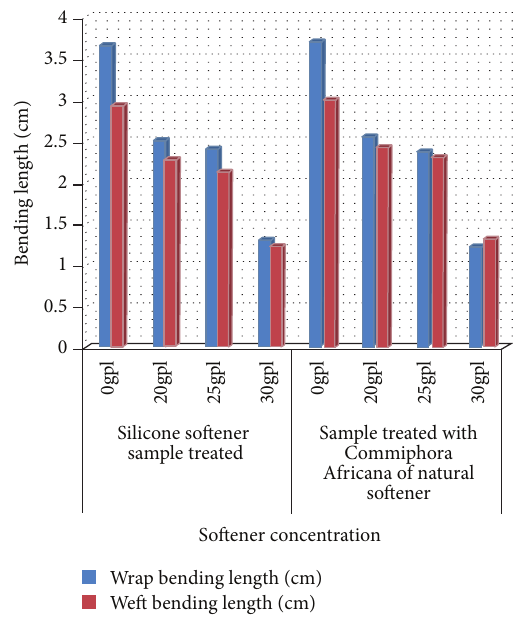
Figure 2: Effect of softener on fabric stiffness.